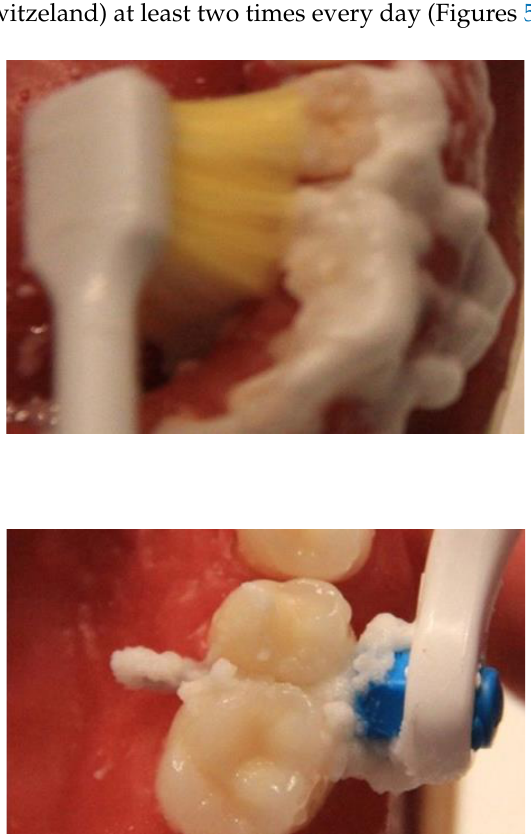
Figure 7. Oral irrigator in action, in order to remove sub-gingival biofilm. 2.6. Methods for a Study Aimed at Demonstrating the Efficacy of the Oral Irrigator in Modifying the Subgingival Bacterial Flora In summary, all 60 patients enrolled in this study received a diagnosis of moderate periodontitis, were treated with non-surgical laser-assisted causal therapy. After one month, a re-evaluation was performed that established the stabilization of the periodontal pathology (non-pathogenic bacterial plaque). Patients were instructed in the previously described home oral hygiene protocol and included in the periodontal maintenance ther- apy program with phase contrast microscope control every 6 months. At time T 0 , all these patients were harvested from subgingival plaque with qualitative analysis under a phase contrast microscope. They were evaluated by the same operator, as explained in paragraph 2.1. Microscopic analysis showed non-pathogenic bacterial flora for each sample (T0). They all underwent a routine professional oral hygiene session. All patients were then divided into two groups at random, A and B. After a profes- sional oral hygiene session, group B was asked to suspend the use of oral irrigator and to continue the home hygiene protocol using only the sonic toothbrush and interdental brushes. Group A after the professional oral hygiene session was told to continue the com- plete protocol at home (sonic toothbrush, interdental brushes, oral irrigator). Three months later, the patients once again underwent the bacterial plaque analysis (T 1 ). At T 0 and T 1 , the classic clinical periodontal indices on the whole mouth were also examined: bleeding on probing, plaque index, probing depth. 2.7. Statistical Analysis The data were obtained and accessed from the Statistical Package for Social Sciences (SPSS). Periodontal index data (BoP, P.I., P.D.) between patients in group A and group B at times T 0 and T 1 were compared with the chi-square statistical test. The threshold for statistical significance was set at p < 0.001. 3. Results Patients belonging to Group B (Table 1), who did not use the oral irrigator for three months, following a protocol at home that included only the use of a sonic toothbrush